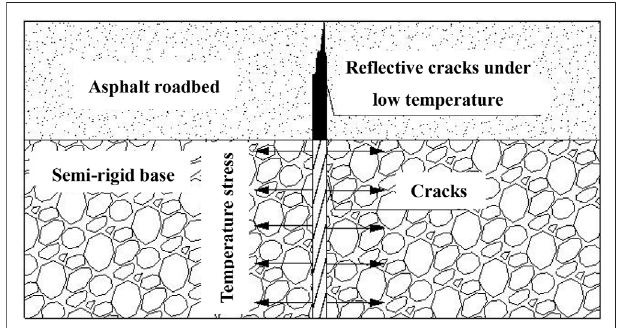
FIGURE 8 | Re fl ective crack from temperature